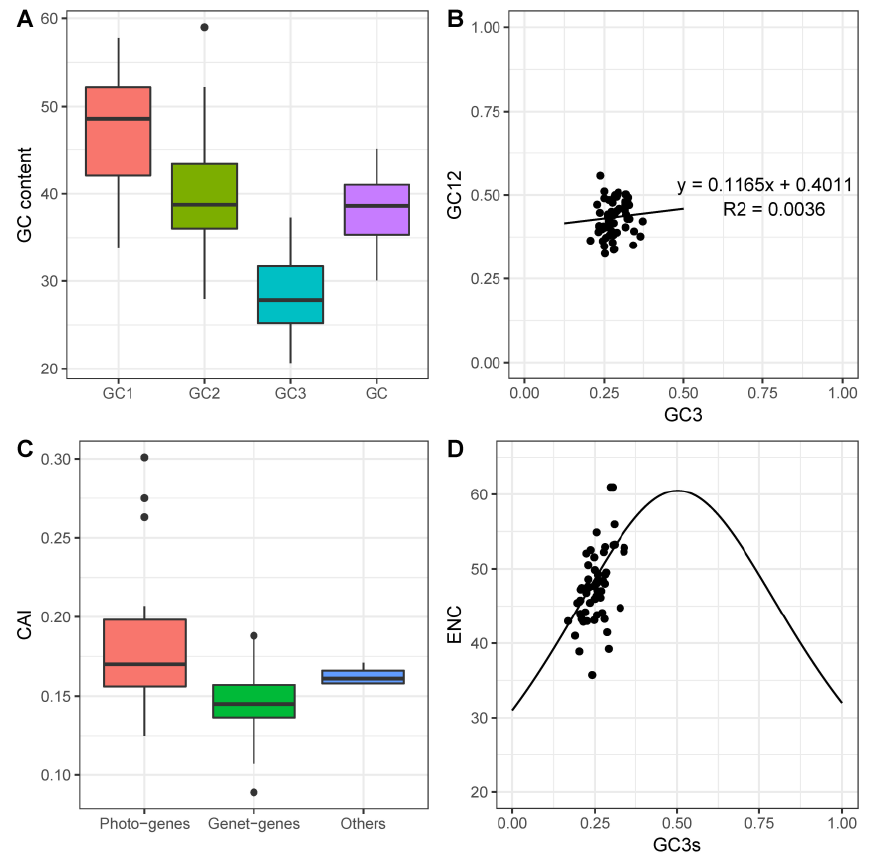
Figure 2. The codon usage pattern of the pomegranate chloroplast (cp) genome. ( A ) GC content on three different positions. ( B ) Neutrality plot (GC12 against GC3). ( C ) The codon adaptation index (CAI) value of gene sets with different functions. ( D ) Relationship between GC3 and effective number of codons (ENC) (ENC-plot). The expected ENC from GC3 is shown as a solid.